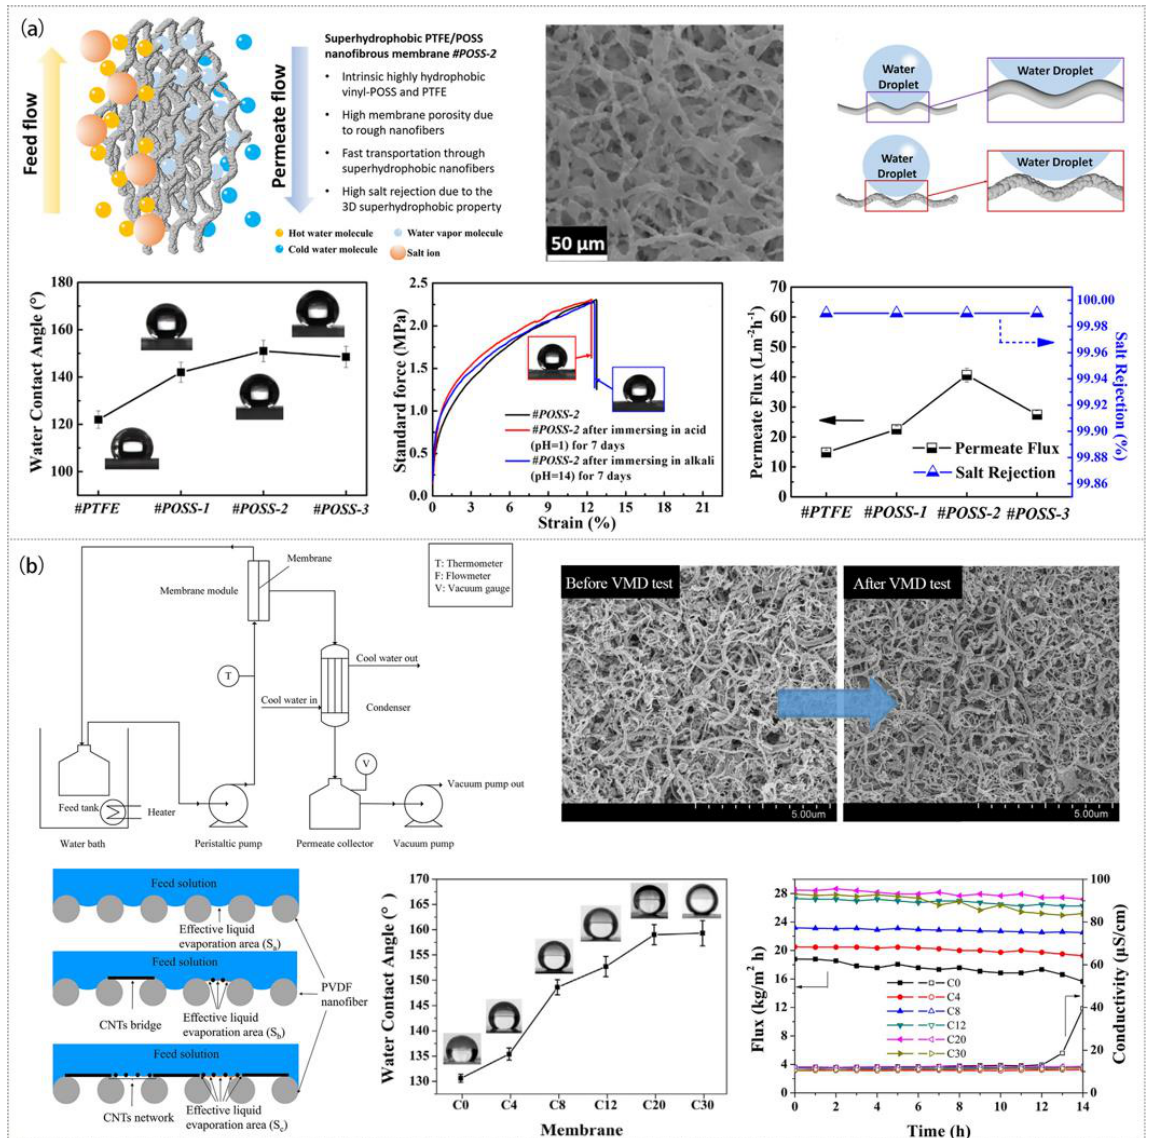
Figure 8. Preparation process, microstructure, and properties of MD membranes: ( a ) PTFE/vinyl- POSS membrane. Reprinted with permission from Ref. [110]. Copyright 2020 Elsevier Ltd. ( b ) PA membrane. Reprinted with permission from Ref. [115]. Copyright 2018 Elsevier Ltd.